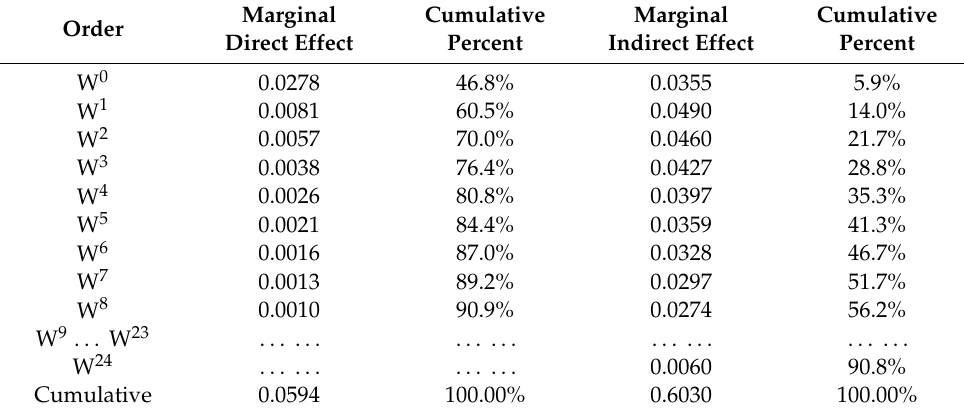
Figure 7. Schematic diagram of higher-order rook spatial weight matrix. W 0 represents center pixel; W 1 represents first-order neighboring pixels; W 2 represents the neighbor of W 1 . Table 6. Spatial partitioning of road2’s